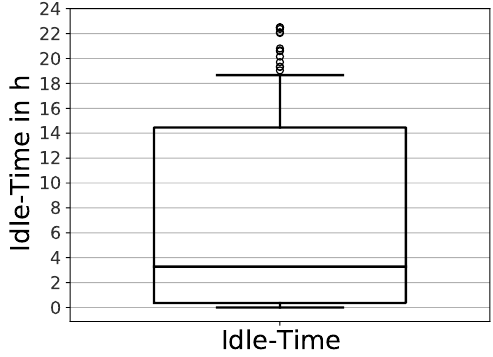
Figure 7. Idle time for the agency site.